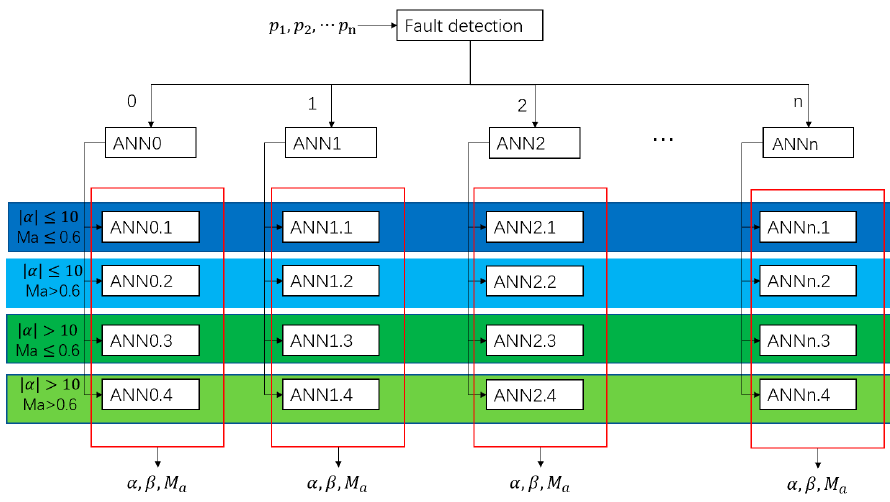
Figure 4. Major architecture of the flush airdata system.